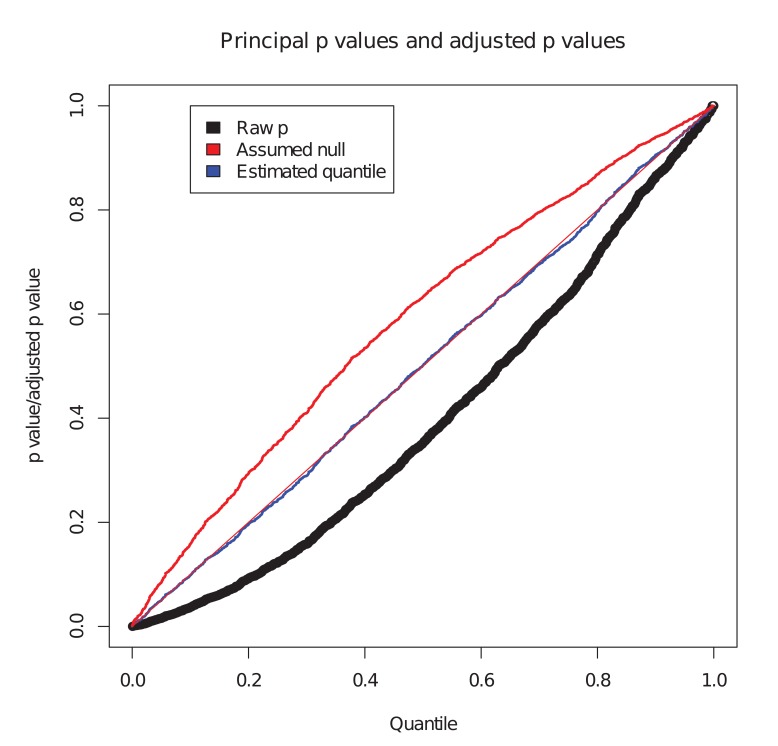
Correction for shared controls.Simulation of GWAS summary statistics for 20000 SNPs, all null for phenotype i and variably null or non-null for phenotype j, with association tested using a shared control group. Black dots show p values for phenotype i at all SNPs with p value for phenotype j less than 0.05, with evident downward bias. Blue dots show our adjustment to expected quantile of p values. The red dots show the expected quantile we would compute if we were to assume incorrectly that all SNPs were null for the conditional phenotype i. We see that this quantity overestimates the true quantile.